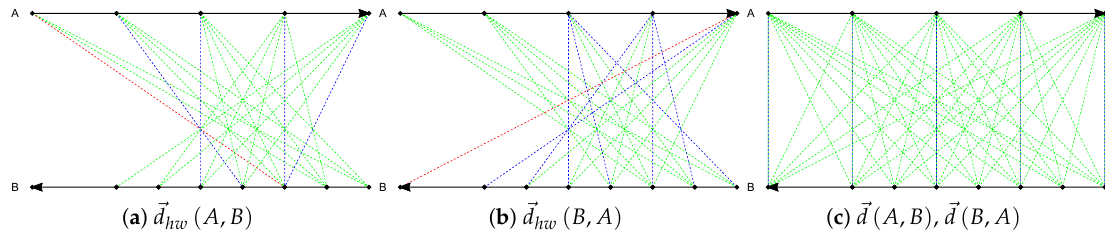
Figure 2. Plots of the distance between two trajectories A and B by directed Hausdorff distance with window (DHD( ω )) and directed Hausdorff distance (DHD). ( a ) distance from A to B by DHD( ω ). ( b ) distance from B to A by DHD( ω ). ( c ) distance from A to B and from B to A by